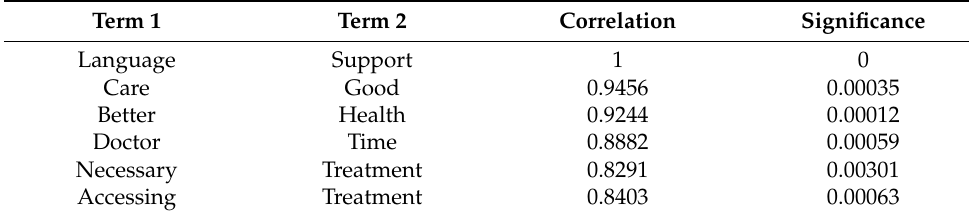
Table 4. Relationships between pairs of words on the first